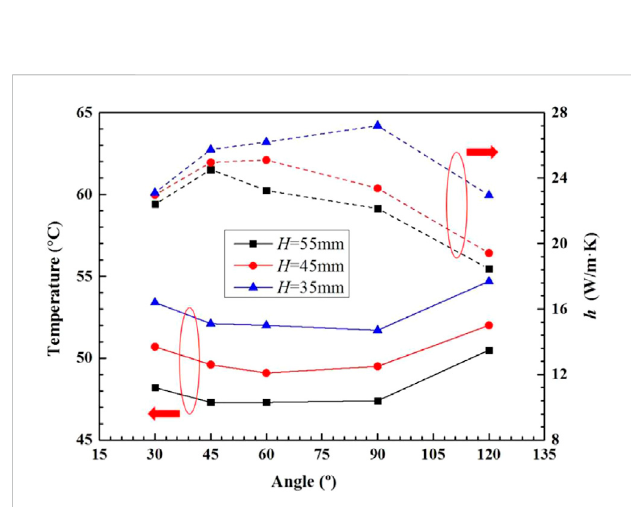
FIGURE 8 The relation of fi n inclination angle and heat transfer performance for the W- type heat sinks with fi n spacing of 8 mm and fi n gap of 8 mm (Zhang et al., 2020).